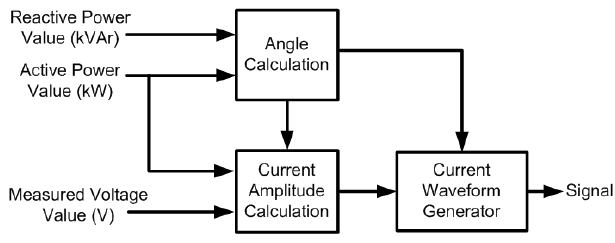
Figure 4. Control block of load model.